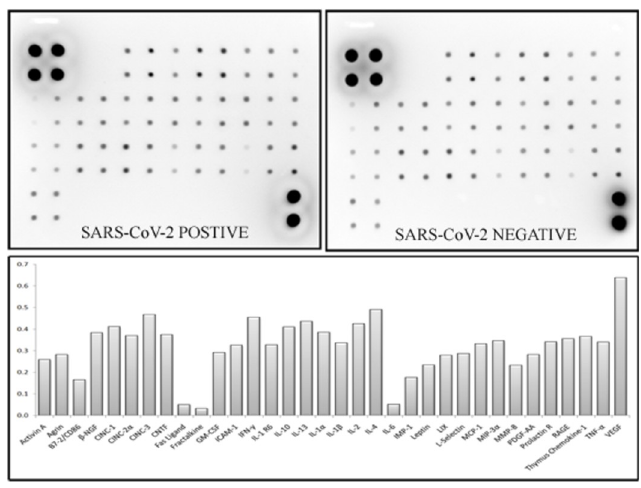
Fig 5. Cytokine protein array analysis. Cytokine protein array analysis for SARS-CoV-2 positive and negative samples. Bottom panel represent the relative expression of the protein based on cytokine protein array analysis.